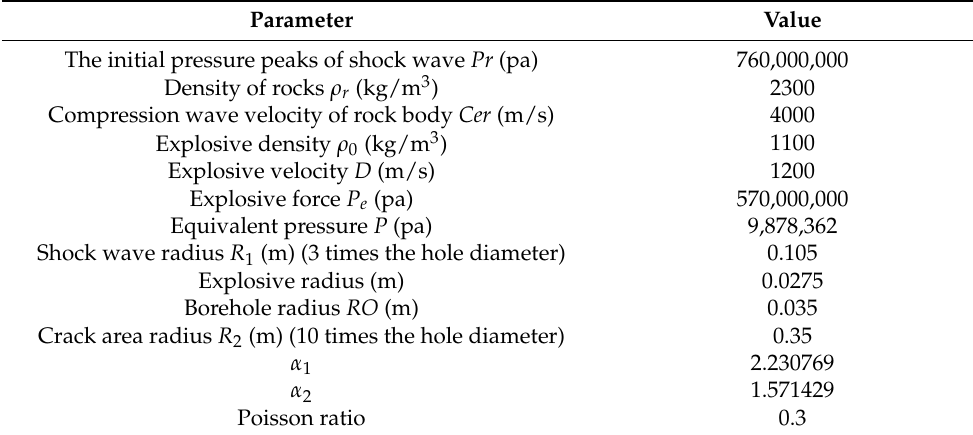
Table 4. Blasting